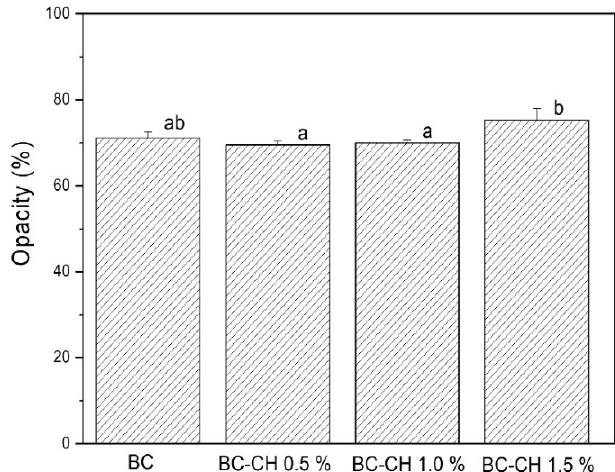
Figure 7. Opacity of BC and BC-CH films coated with various concentrations of chitosan. Average ± standard deviation. Letters (a, b) indicate significant differences ( p < 0.05) between treatments.